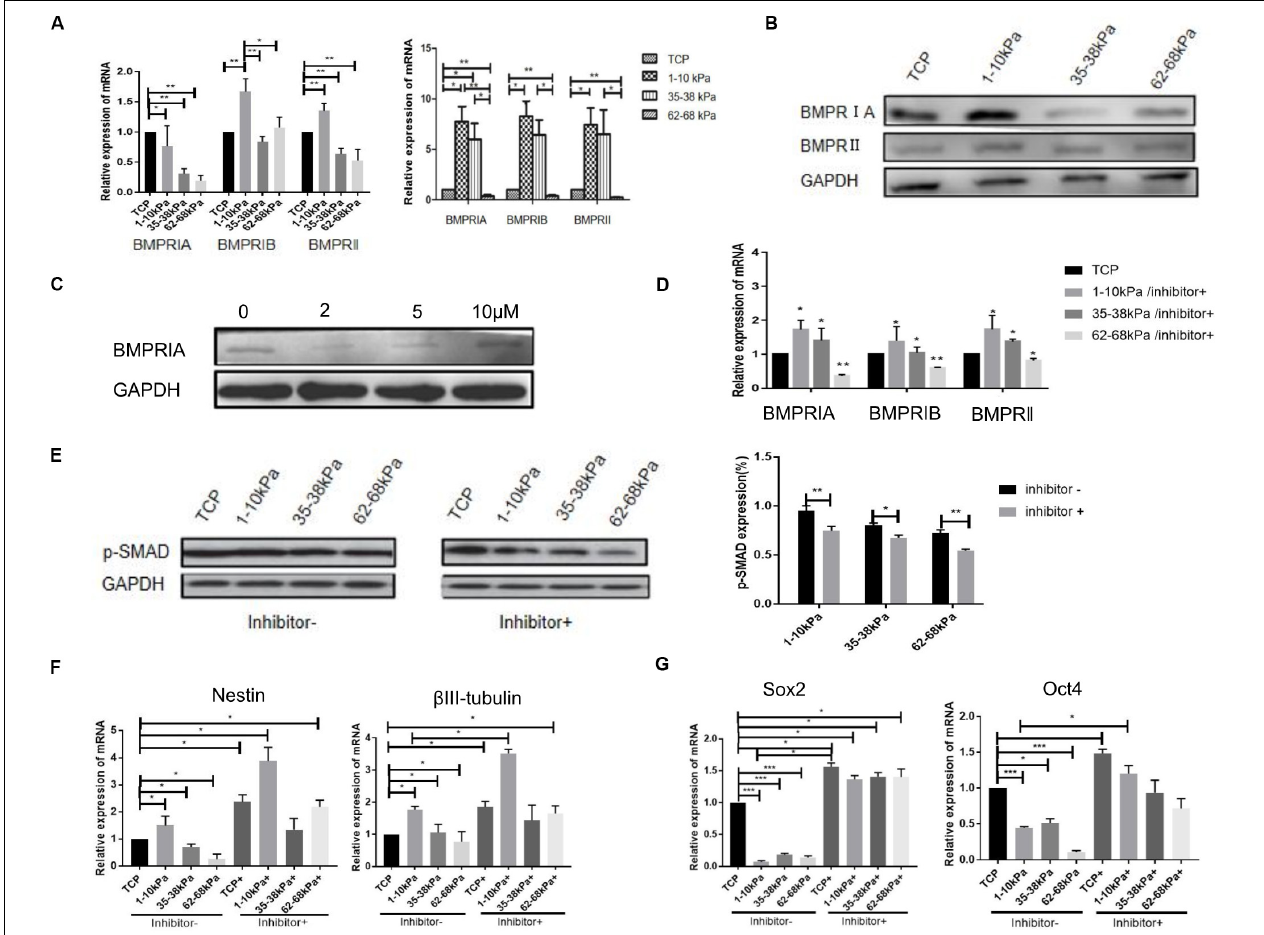
FIGURE 2 | BMPR is involved in stiffness-mediated neural differentiation of hUC-MSCs. (A) qRT-PCR detection of BMPR subtypes expression at day 1 and day 7 (Results are presented as mean ± SEM, n = 5 independent experiments, * p < 0.05, and ** p < 0.01). (B) Expression of BMPR subtypes detected using western blotting, and statistical analysis diagram (Results are presented as mean ± SEM, n = 3, * p < 0.05, and ** p < 0.01). (C) The best concentration of BMPR inhibitor was determined using western blotting, the best concentration of inhibitor was 2 µ M ( n = 3 independent experiments). (D) The cells were collected at day 7 for detection of BMPR expression after stiffness groups adding inhibitor using RT-qPCR (Results are presented as mean ± SEM, n = 5 independent experiments, * p < 0.05, and ** p < 0.01). (E) Expression of p-SMAD was detected using western blotting before and after BMPR inhibition, and statistical analysis diagram (Results are presented as mean ± SEM, n = 3, * p < 0.05, and ** p < 0.01). (F) qRT-PCR analysis of Nestin and β III-tubulin expression after BMPR inhibition for 24 h. Statistical analysis was performed using one-way ANOVA. Statistical significance was defined as p < 0.05. Results are presented as mean ± SEM ( n = 5 independent experiments, p < 0.05). (G) qRT-PCR analysis of SOX2 and OCT4 expression after BMPR inhibition for 24 h. Statistical analysis was performed using one-way ANOVA. Statistical significance was defined as p < 0.05. Results are presented as mean ± SEM ( n = 5 independent experiments, p < 0.05, and *** p <